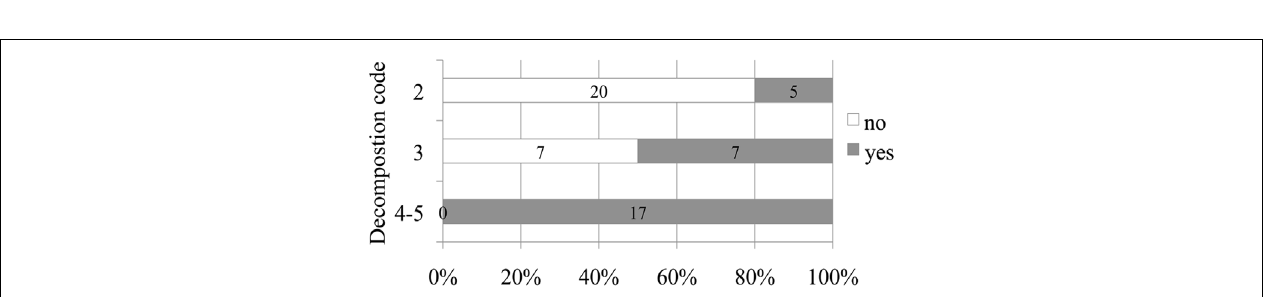
FIGURE 1 | Number and relative percentage of animals with intravascular bubbles (in dark gray) compared to those without bubbles (in white) regarding to decomposition code.